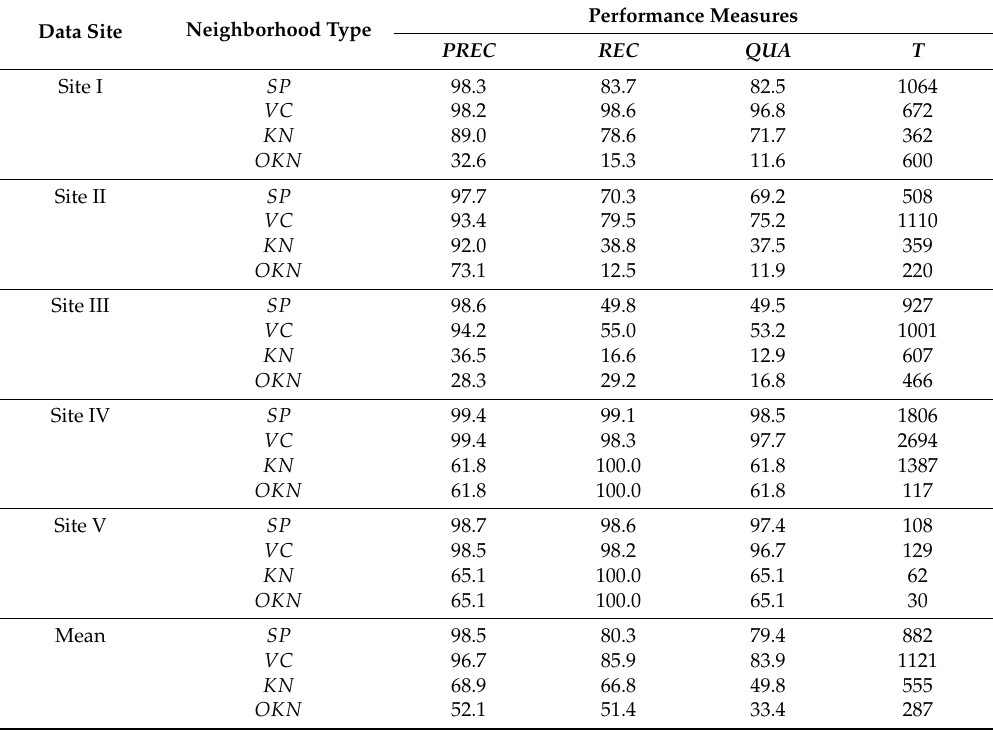
Table 3. Classification performance for different multi-scale neighborhood types ( PREC = precision rate in %, REC = recall rate in %, QUA = quality rate in %, T = processing time in seconds, SP = spherical neighborhood, VC = vertical cylindrical neighborhood, KN = k -nearest neighborhood, and OKN = optimal k -nearest